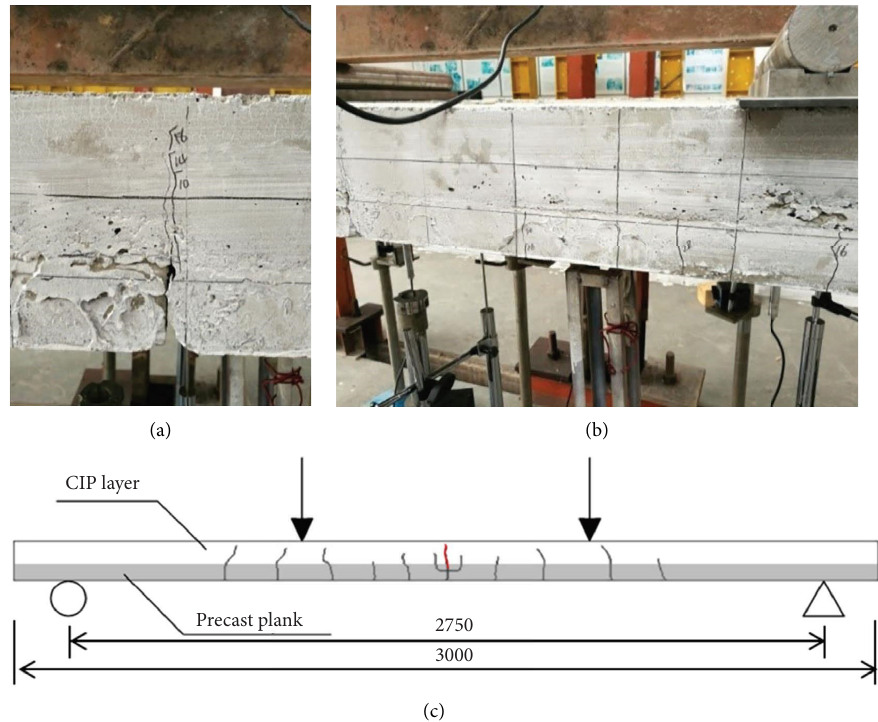
Figure 9: Failure phenomenon of LGSB1. (a) Cracking at midspan. (b) Cracking in the precast plank. (c) Crack